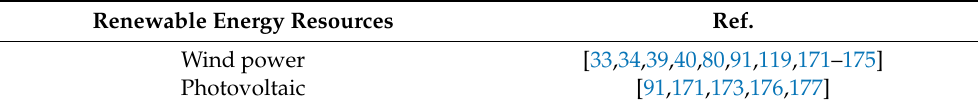
Table 7. Classification of references based on the renewable energy resources used in